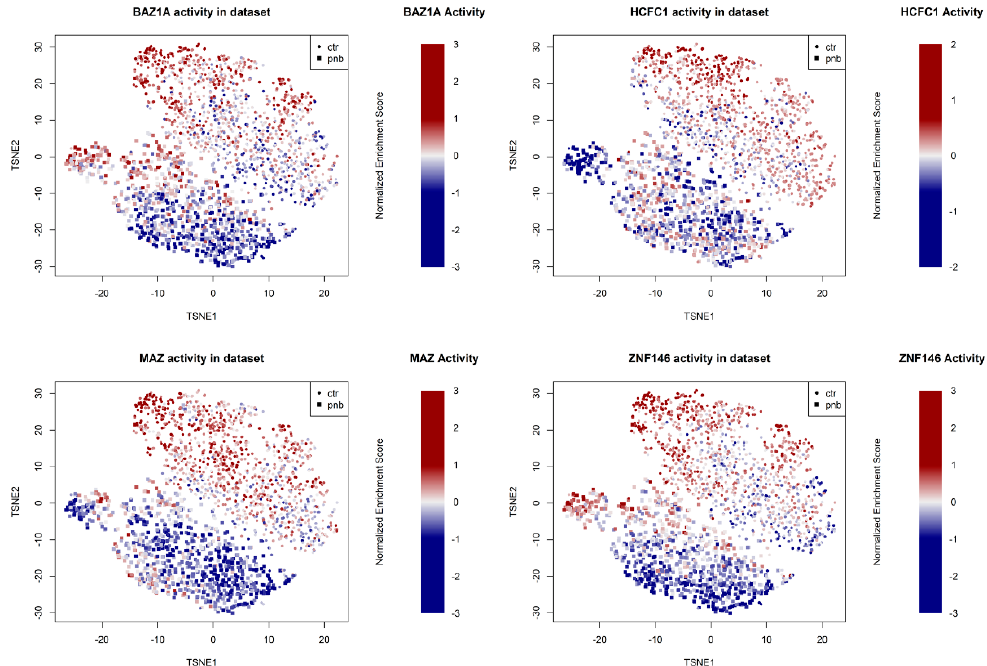
Figure 5. t-SNE projection (calculated after removal of ambiguous multihashtag cells) of the single-cell experiment. Colors are proportional to the normalized enrichment score of the indicated TF network (BAZ1A, HCHFC1, MAZ, and ZNF146) relative to the average of the dataset. Symbols indicate whether the cell was PNB-treated (square) or a control (small circle).